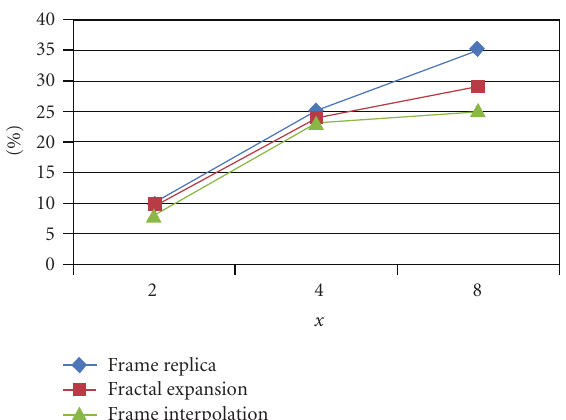
Figure 9: Measured blurring for CrowdRun sequence.